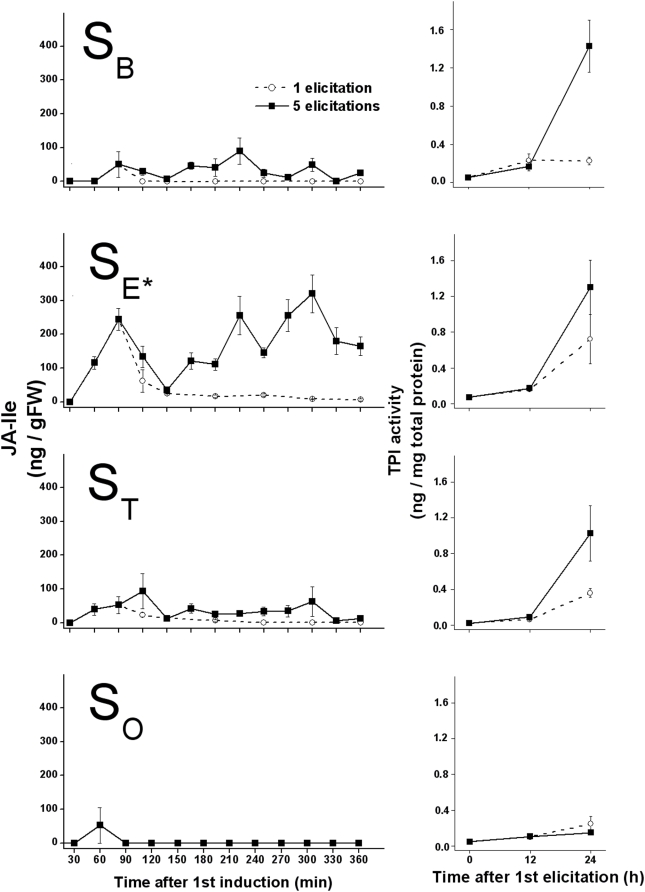
Early JA-Ile accumulations and later TPI activity in leaf sectors elicited once and five times reveals the proportionally of the responses.Increases in TPI activity (right column) in response to a single elicitation (open circles on dotted lines) are proportional to early increases in JA-Ile accumulation (left column): TPI activity differs among laminal sectors, with SE* having significantly higher TPI activity than SO and SB (Fisher's PLSD, P<0.05) and marginally significantly higher TPI activity than ST (Fisher's PLSD, P = 0.10). However, TPI activities after 5 successive elicitations (1 per h; solid squares on solid lines) do not differ significantly among SB, SE*, and ST (ANOVA, F = 0.48, P = 0.63), although all values are higher than those elicited by a single elicitation in the respective laminal sectors. In SO, only 1 of the 68 analyzed sectors contained detectable JA-Ile and TPI activity did not differ from un-induced levels. Values represent JA-Ile or TPI activity mean±S.E. (n = 4 and 5, respectively).